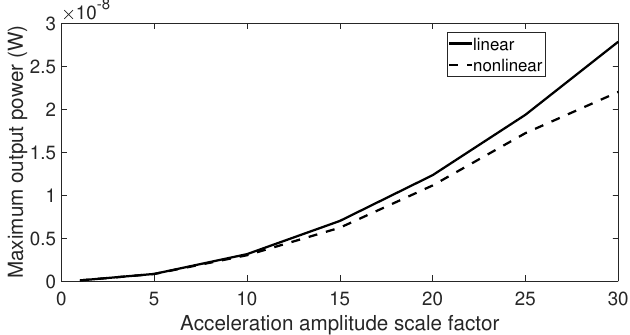
Figure 16. Maximum output power response for the linear and nonlinear prototypes under center frequency sweeping aquarium excitation when the acceleration amplitude is scaled by a factor.